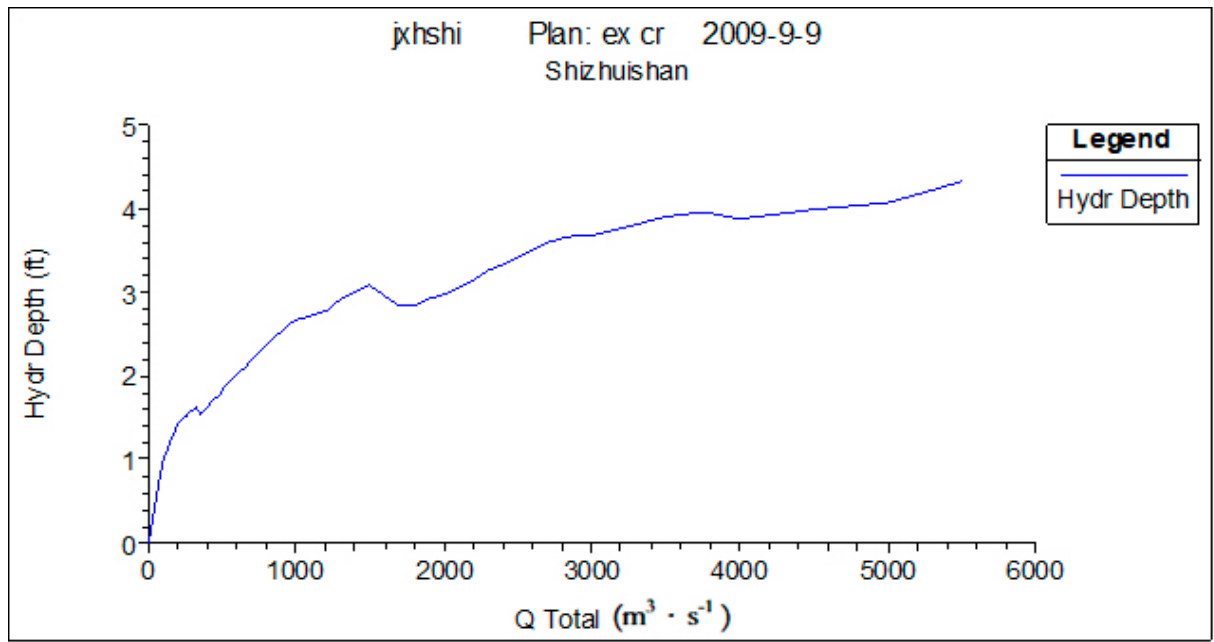
Figure 3. Water depth change at Shizuishan cross under different flows. Source: China Water Resources Yearbook, 2018.